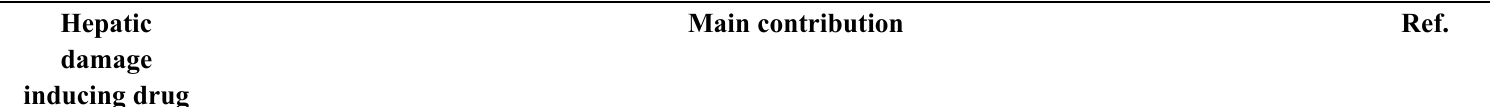
Table 1. The most frequently used mushrooms in hepatoprotection studies and the main contribution of each